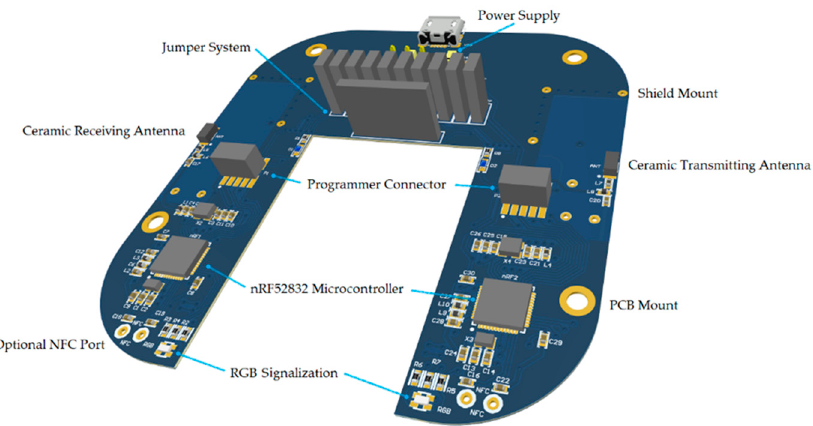
Figure 2. Three-dimensional visualization of a radio tomography probe designed by CBRTI Sp. z o.o. Research and Development Center with a description of characteristic elements.